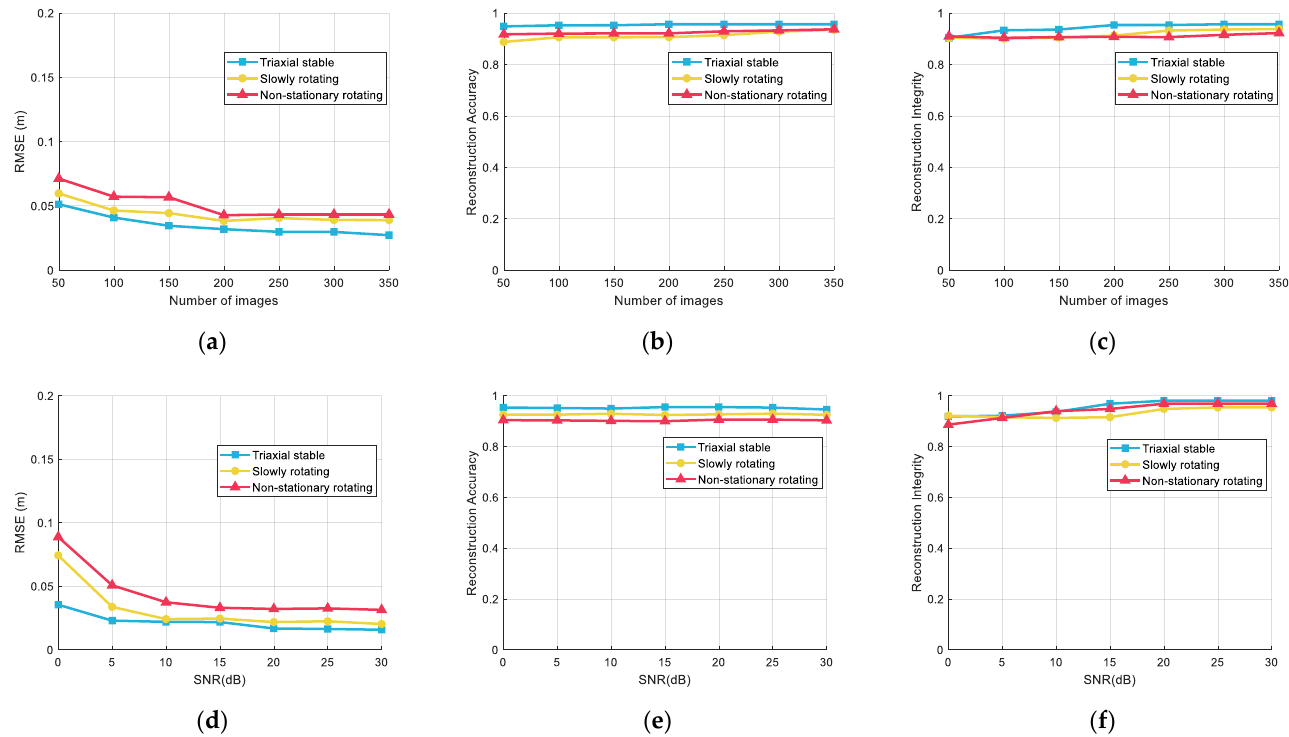
Figure 10. The ( a ) RMSEs, ( b ) reconstruction accuracies, and ( c ) reconstruction integrities when using different numbers of ISAR images when the HST is in different motion states. The ( d ) RMSEs, ( e ) reconstruction accuracies, and ( f ) reconstruction integrities when using different SNRs of ISAR images when the HST is in different motion states.